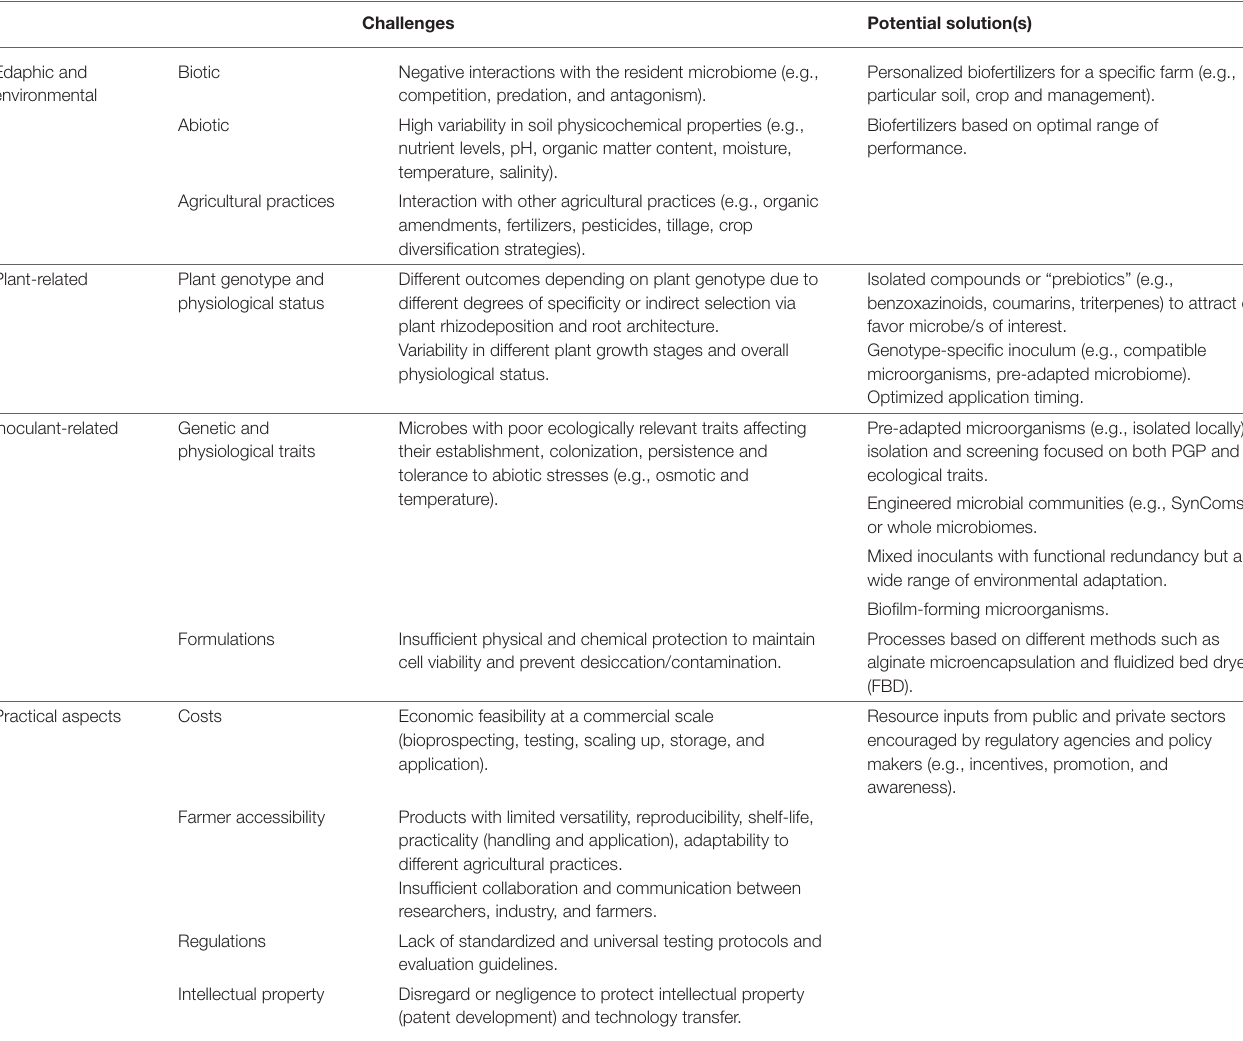
TABLE 1 | Challenges associated with biofertilizer success and potential solutions relying on novel